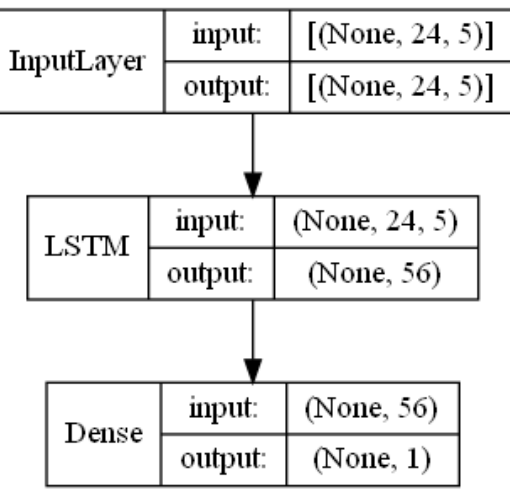
Figure 9. Model architecture with LSTM and Dense